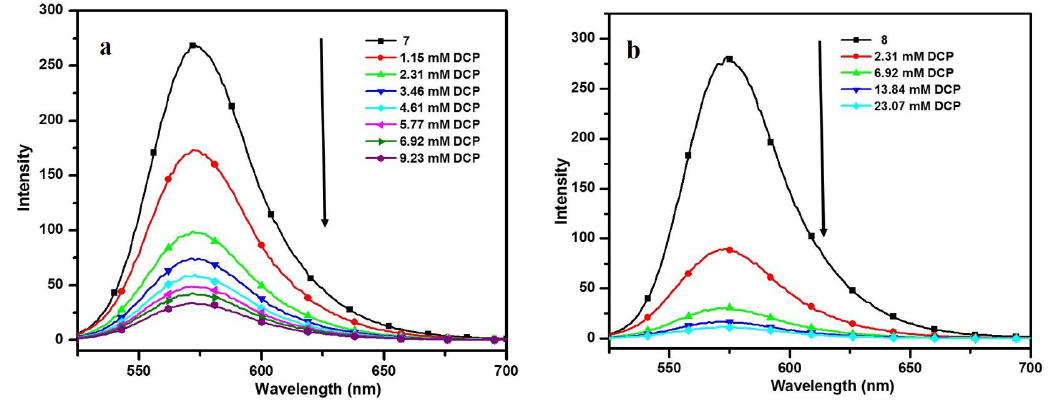
Figure 6. Fluorescence spectra upon titration of compounds 7 ( a ) and 8 ( b ) with DCP. Table 2. The Stern-Volmer constants, binding constants, and number of binding sites of the 3-(4-diethylaminocinnamoyl)coumarins with DCP in chloroform. Compd. λ Ab.